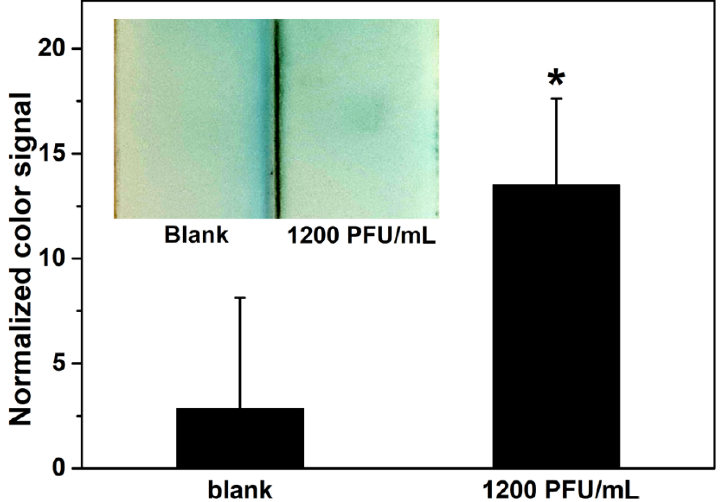
Figure 5. Normalized colorimetric signal from mLFA detection of uninoculated saliva (184.1% RSD) and 1200 PFU/mL (30.6 %RSD, p -value 0.051 vs. uninoculated saliva marked as * in Figure 5) of SARS-CoV-2 inoculated saliva ( n = 3). The inset image shows typical detection results with saliva samples.